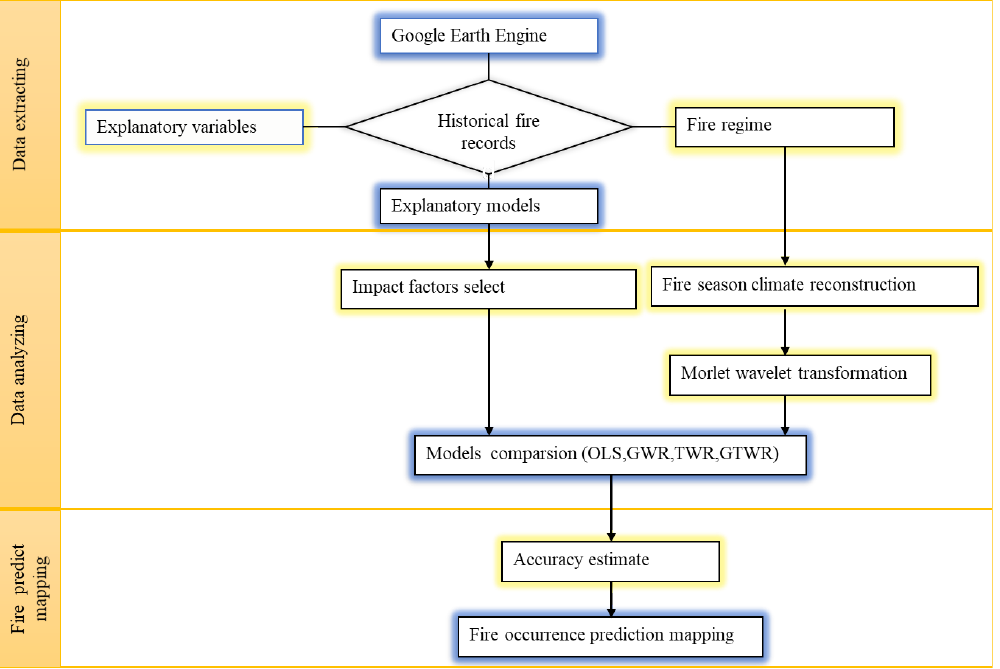
Figure 2. An overview of the proposed